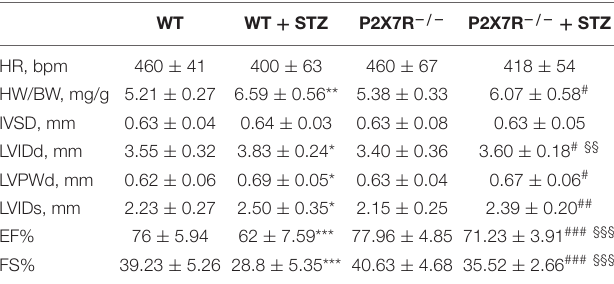
TABLE 3 | Biometric and echocardiographic parameters of the C57BL/6 gene knockout experimental